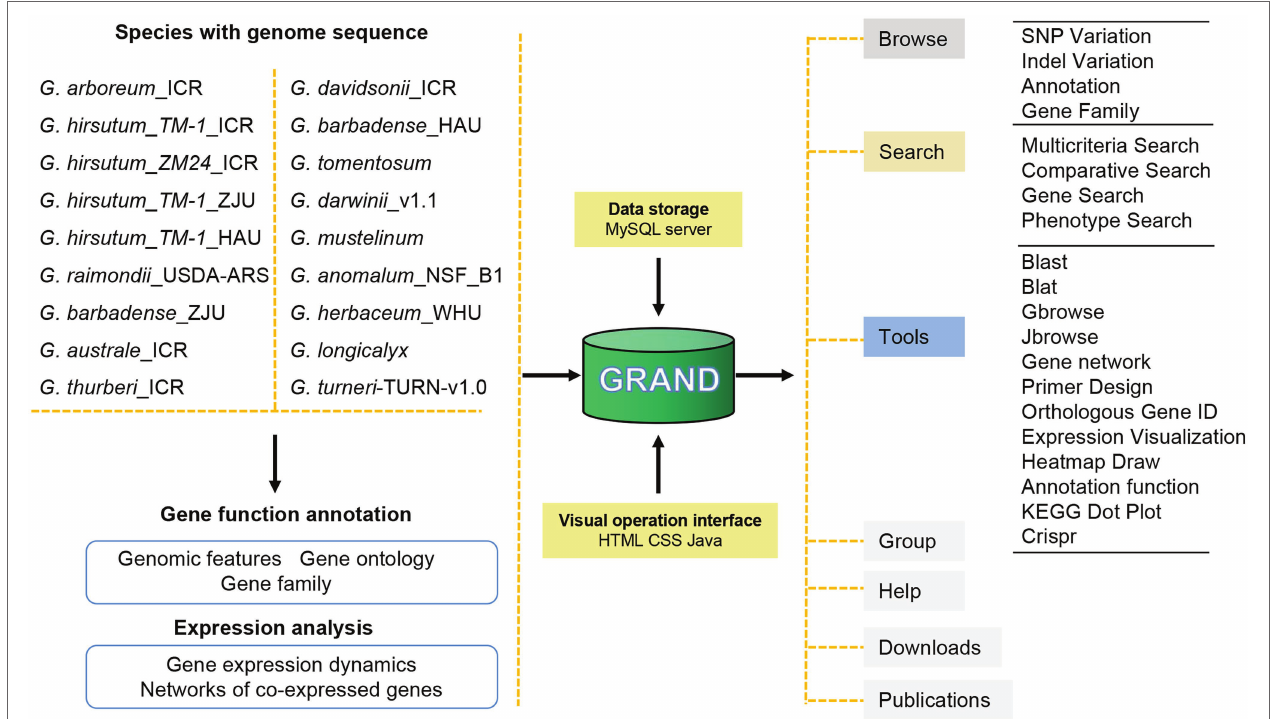
FIGURE 1 | Schematic of GRAND database structure and web interface features. GRAND gathers 18 genomes, four transcriptomes of cotton and associated genome variations, and annotations data. All data are stored in a MySQL